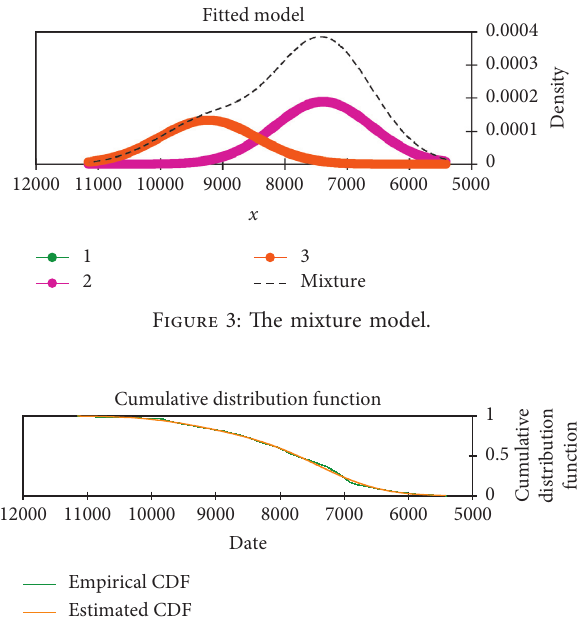
Figure 4: The mixture model. It is clear that the estimated CDF is very close to empirical CDF, which confirms the accuracy of the